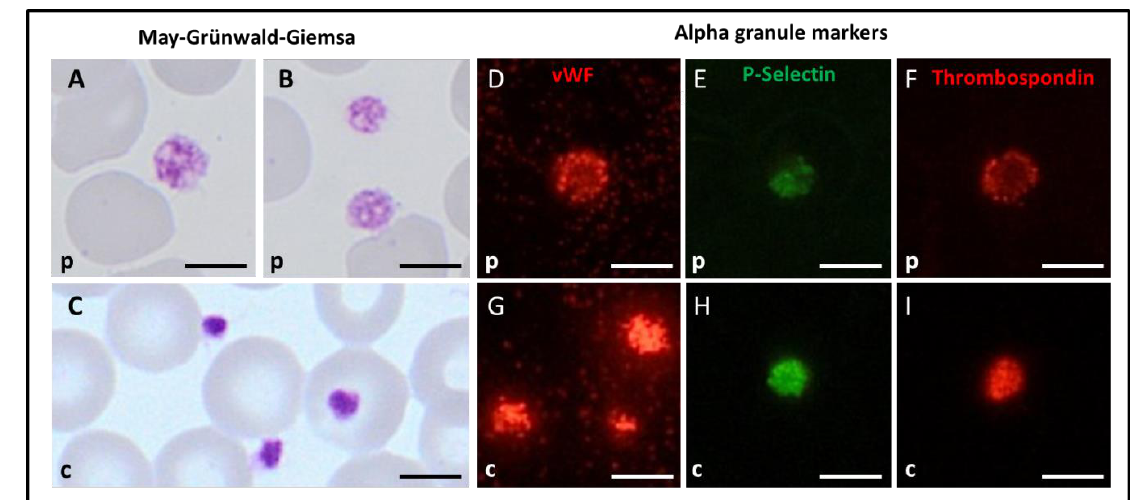
Figure 4. ( A – C ) In light microscopy, the patient’s platelets displayed increased size and reduced granularity compared to control. In addition, vacuoles were sometimes evident, particularly in the larger platelets. ( D – I ). In immunofluorescence microscopy, a mild reduction in the expression of the alpha granule markers von Willebrand factor, vWF ( D ), P-selectin ( E ), and thrombospondin ( F ) was noticeable in comparison to controls ( G – I ). Legend. p = C I.1; c = healthy control. Scale bars corre- spond to 5 µm.